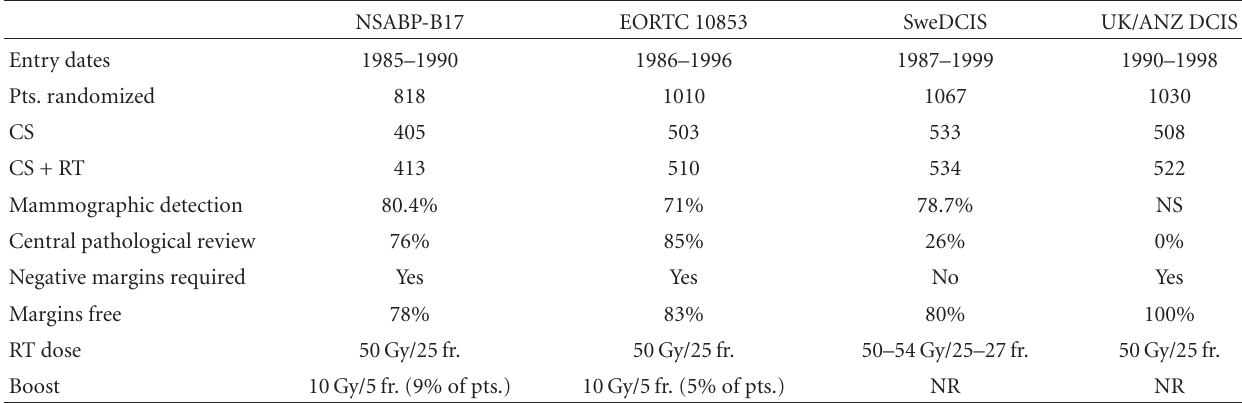
Table 1: Characteristics of the prospective randomized trials.